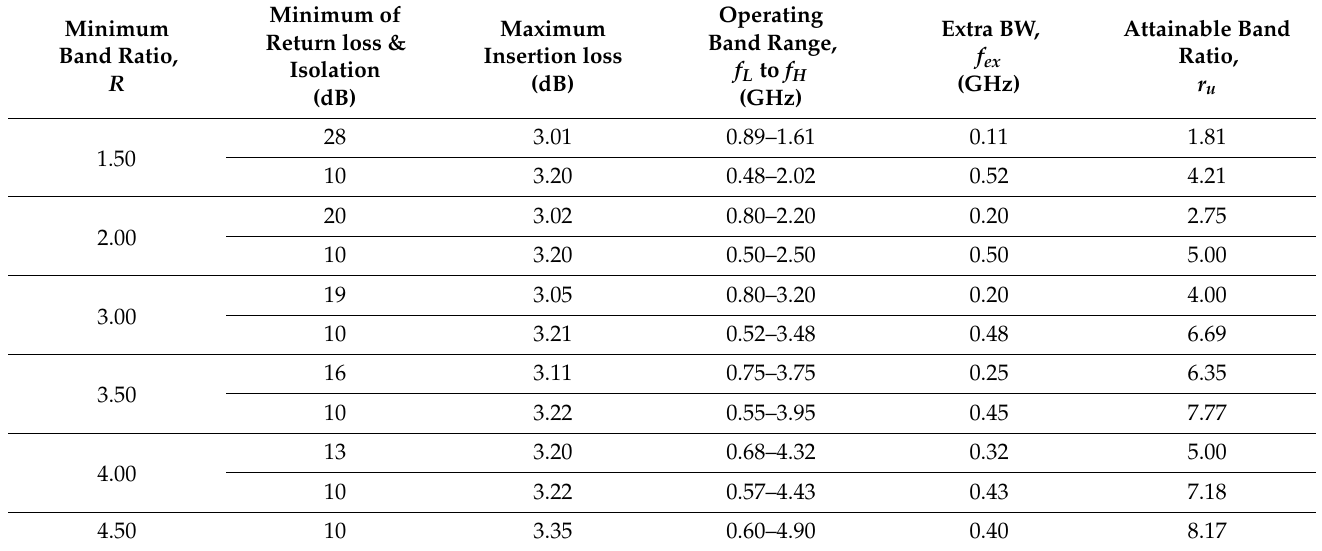
Table 3. Limitation on Wideband